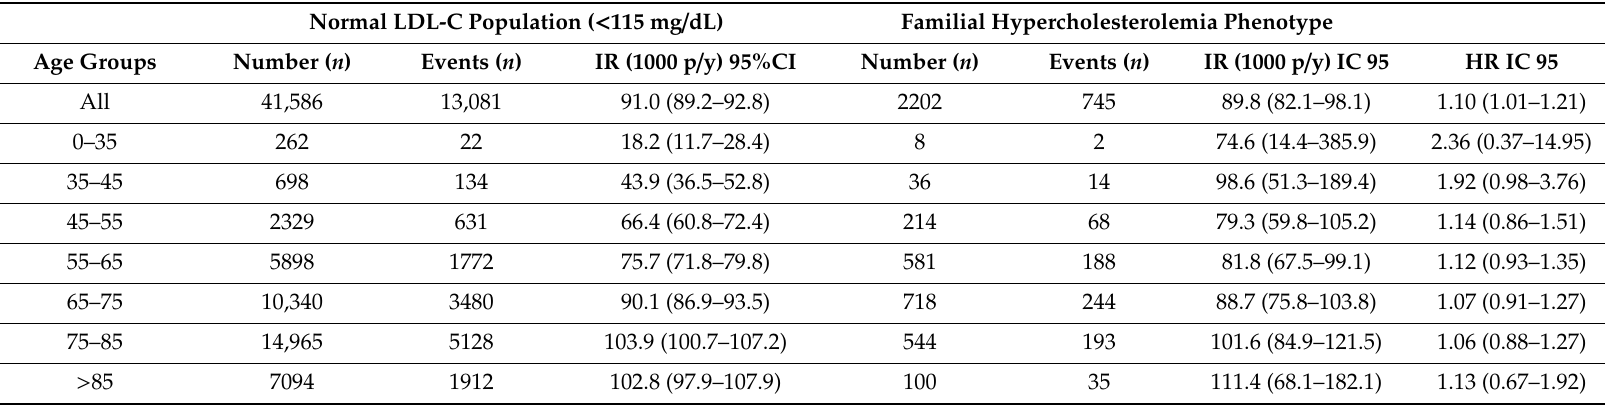
Table 3. Incidence rate (1000 person / years) and hazard ratio of atherosclerotic cardiovascular disease by age in secondary prevention. Normal LDL-C Population ( < 115 mg /